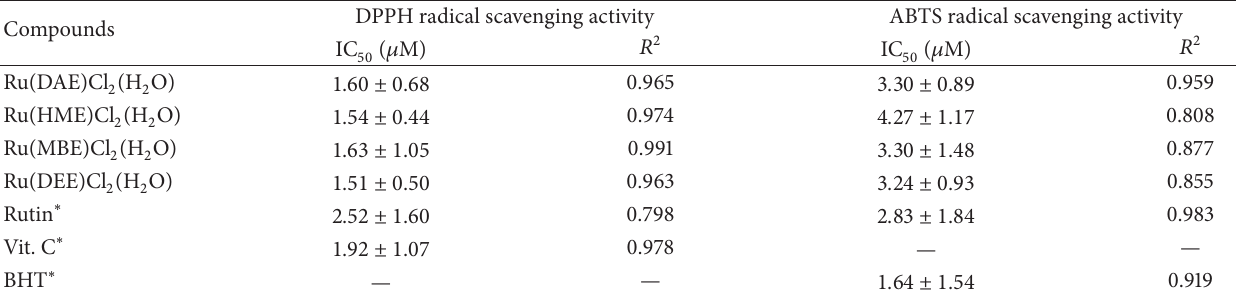
Table 2: Radical scavenging abilities (IC 50 ± SD, 𝜇 M) of Ru(III)-Schiff base complexes and standard drugs.